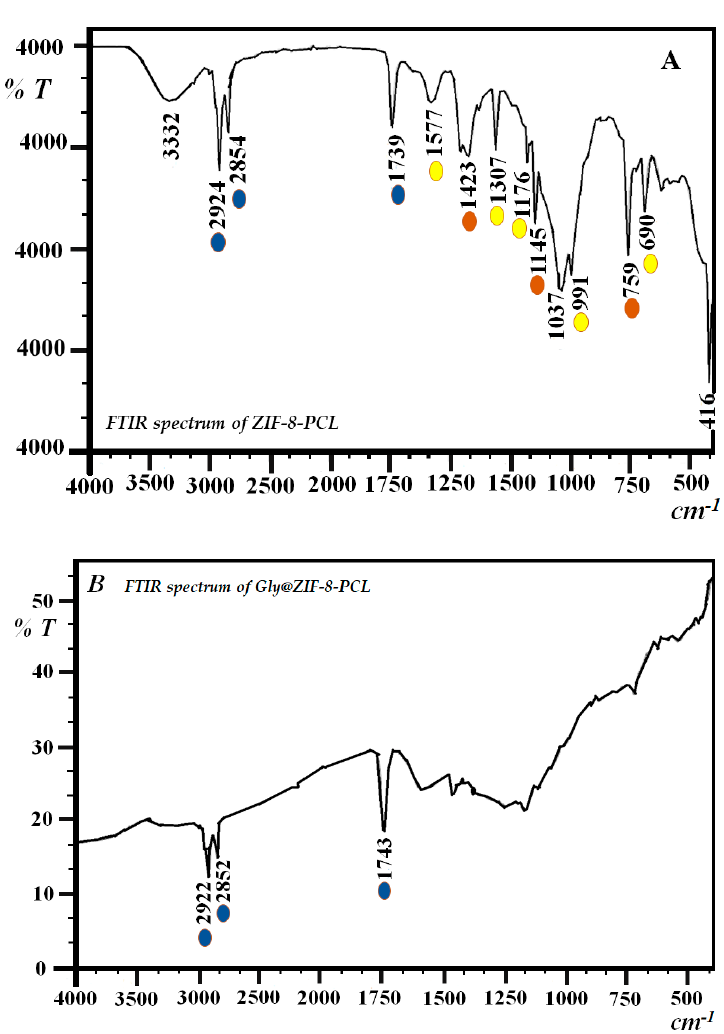
Figure 4 . FTIR spectrum of: ( A ) ZIF-8-PCL and ( B ) Gly@ZIF-8-PCL. Figure 4. FTIR spectrum of: ( A ) ZIF-8-PCL and ( B )